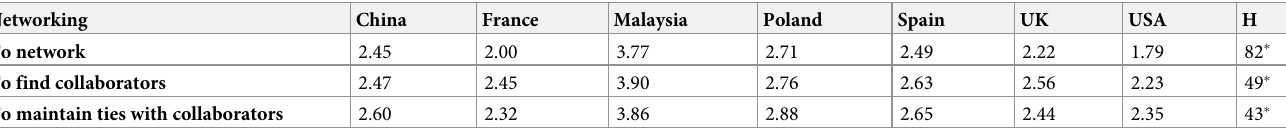
Table 13. Country differences for networking (mean).